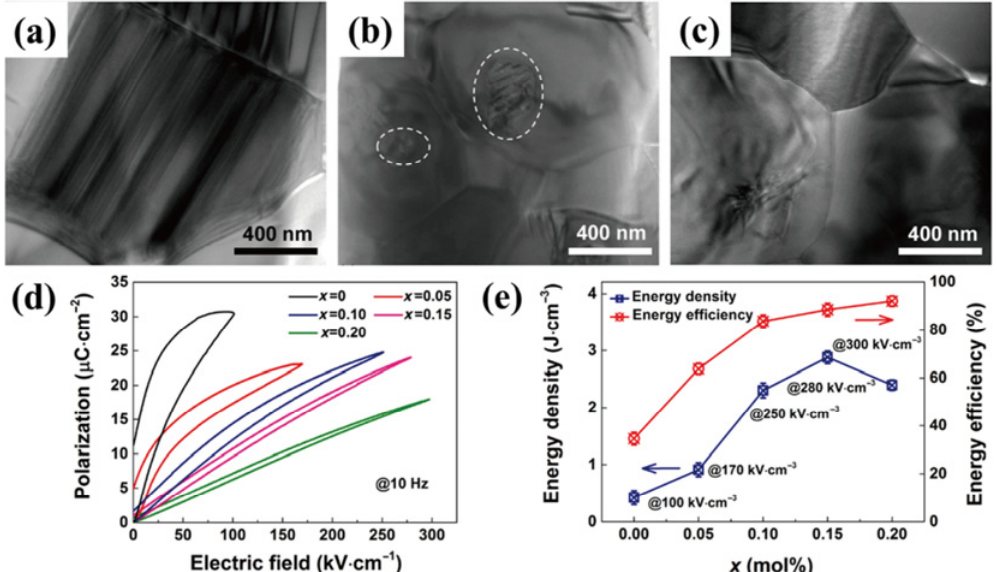
Fig. 9 Bright-field TEM micrographs of (1 − x )BT– x BMZ ceramics for (a) x = 0, (b) x = 0.05, and (c) x = 0.15. (d) P – E loops and (e) energy storage performance of (1 − x )BT– x BMZ ceramics. Reproduced with permission from Ref. [32], © Elsevier Ltd.